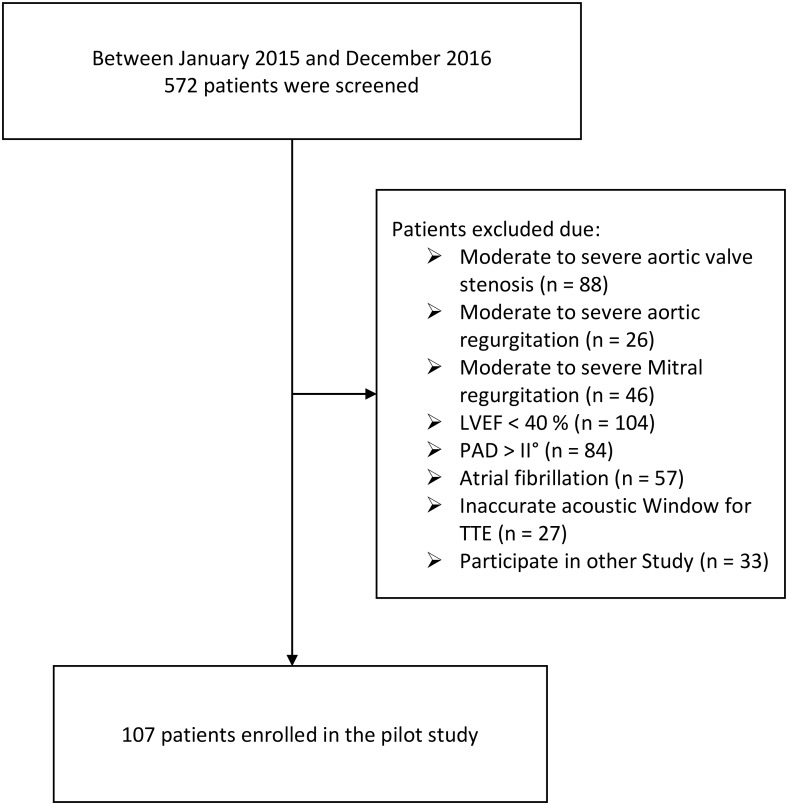
Study flow chart.LVEF, Left ventricular ejection fraction; PAD, Peripheral artery disease; TTE, transthoracic echocardiography.